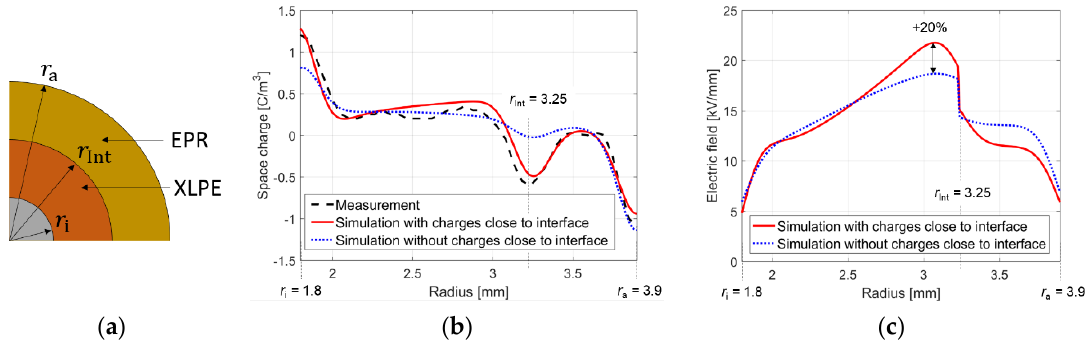
Figure 15. ( a ) Sketch of the dual dielectric interface; ( b ) measured and simulated space charge distribution, with and without consideration of accumulated chares in the vicinity of the interface; ( c ) corresponding electric field of the simulated charge distribution [70,84].